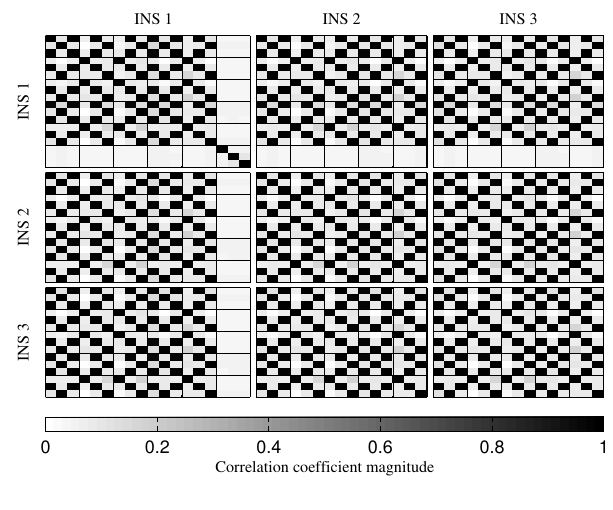
Figure 14. The position estimation error standard deviation computed by the navigation filter and the one obtained from Monte Carlo simulation, when the GPS receiver is not present.